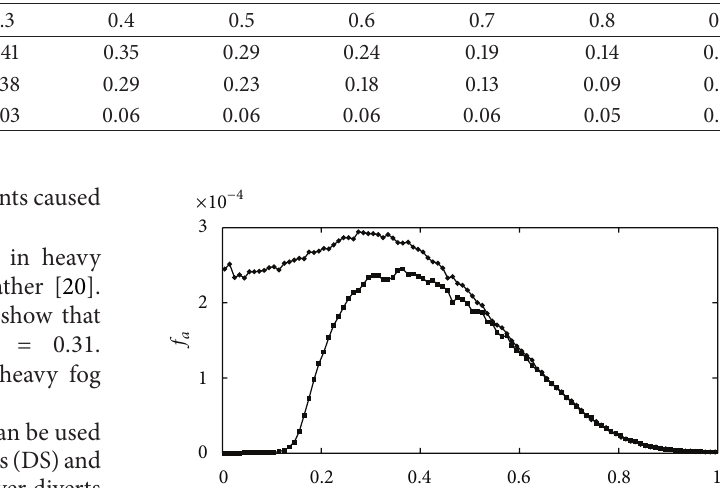
Figure 3: Relationship between traffic capacity and 𝜌 : (a) heavy fog condition and (b) normal weather condition. Table 2: The relative difference of traffic capacity in heavy fog and normal weather.